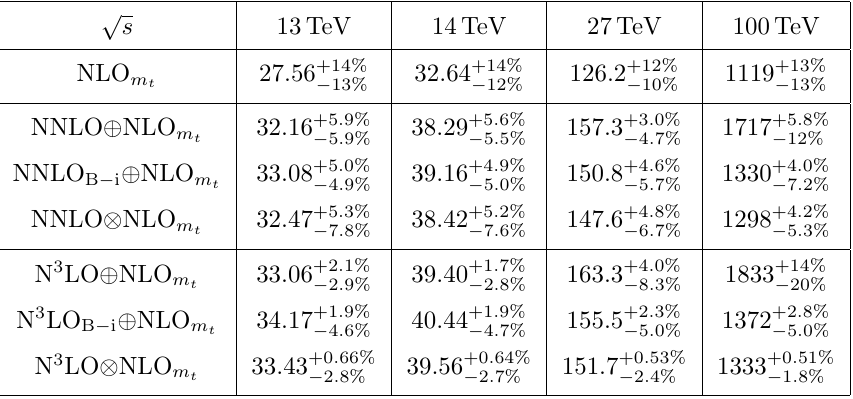
Table 4 . The inclusive total cross sections (in unit of fb) of Higgs boson pair production at di(cid:11)erent p centre-of-mass energies s within the considered approximations. The quoted relative uncertainties are from the 9-point scale